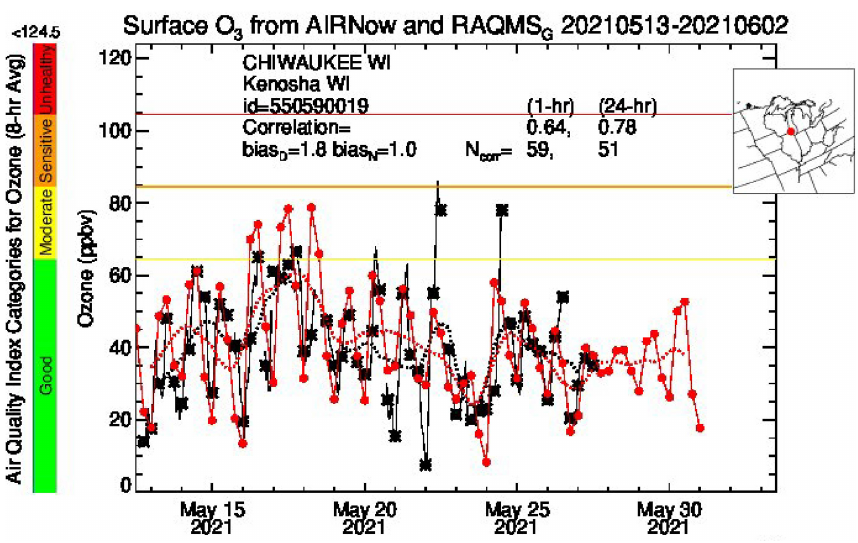
Figure 5. The 8h ozone concentrations from RAQMS forecast (red) and observations (black) for 13–26 May 2021 at Chiwaukee Prairie. Table 1. UAS flight days and conditions for the WiscoDISCO-21 field campaign. Flight patterns A and B are depicted in Fig.